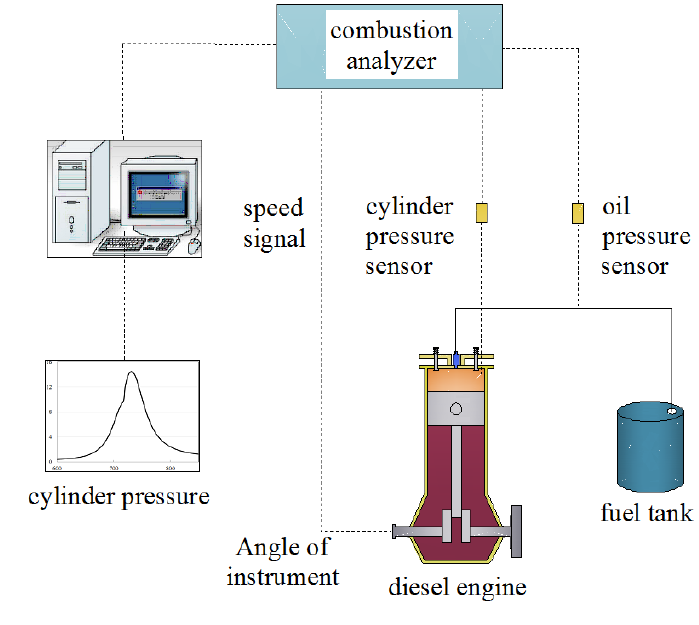
Figure 3. Connection of the experimental